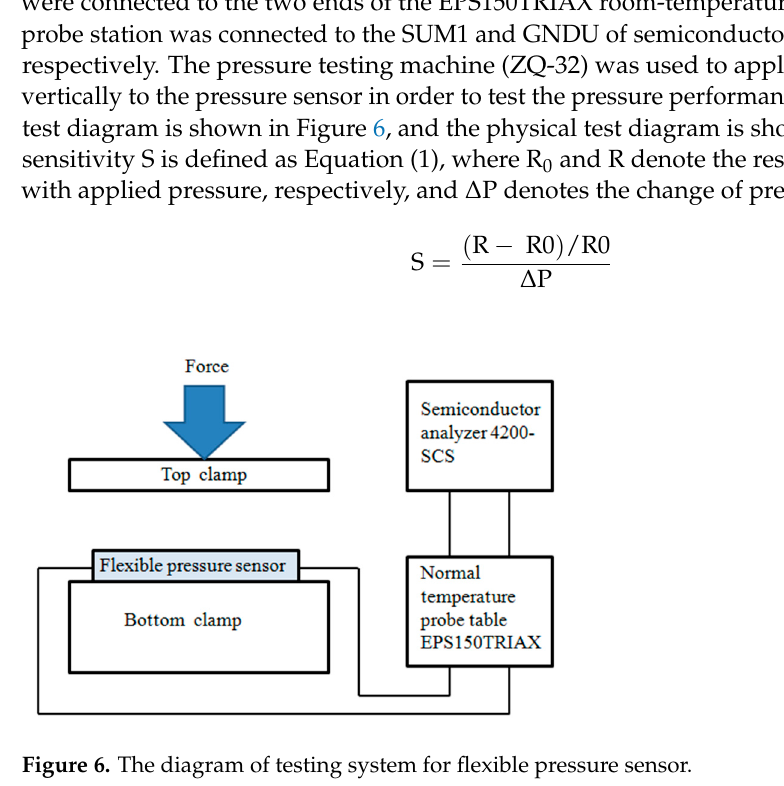
after transfer, indicating that the graphene has fewer defects after the transfer.